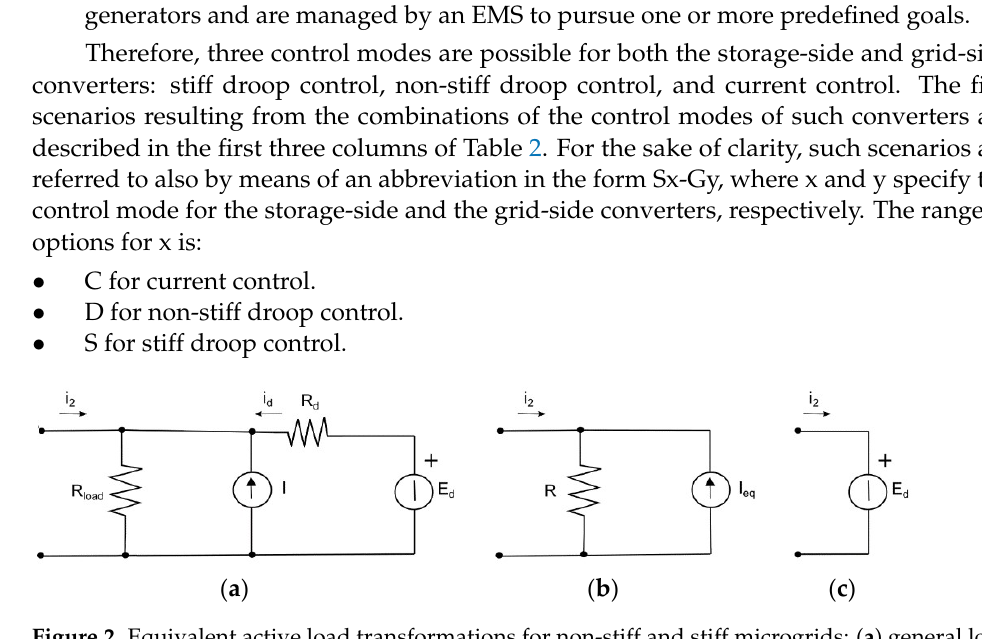
Figure 2. Equivalent active load transformations for non-stiff and stiff microgrids: ( a ) general load model for storage converter; ( b ) equivalent load model considered in scenarios #1–#4; ( c ) equivalent load model considered in scenario #5. Table 2. Possible combinations of microgrid scenarios, converter and load models, and control schemes for the Split-pi. Microgrid